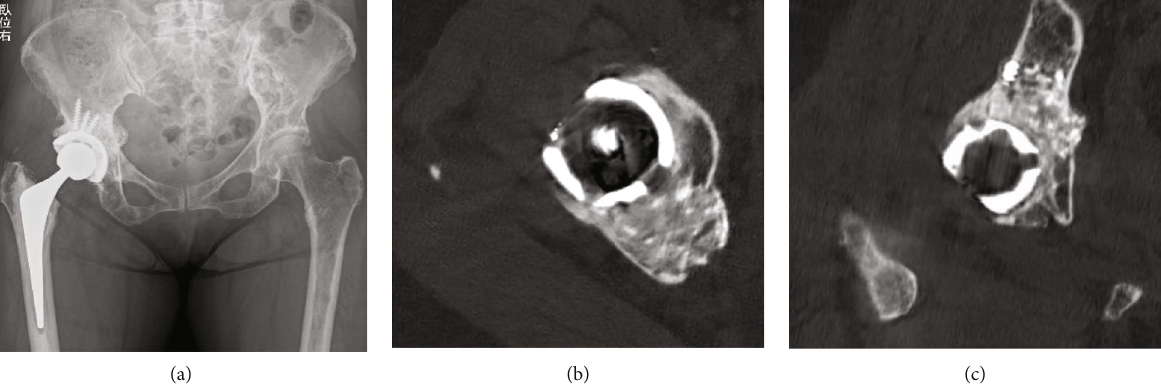
Figure 5: (a) Plain radiograph and CT images (b) axial and (c) coronal at 1 year after operation reveal incorporation of the acetabular bone grafts.